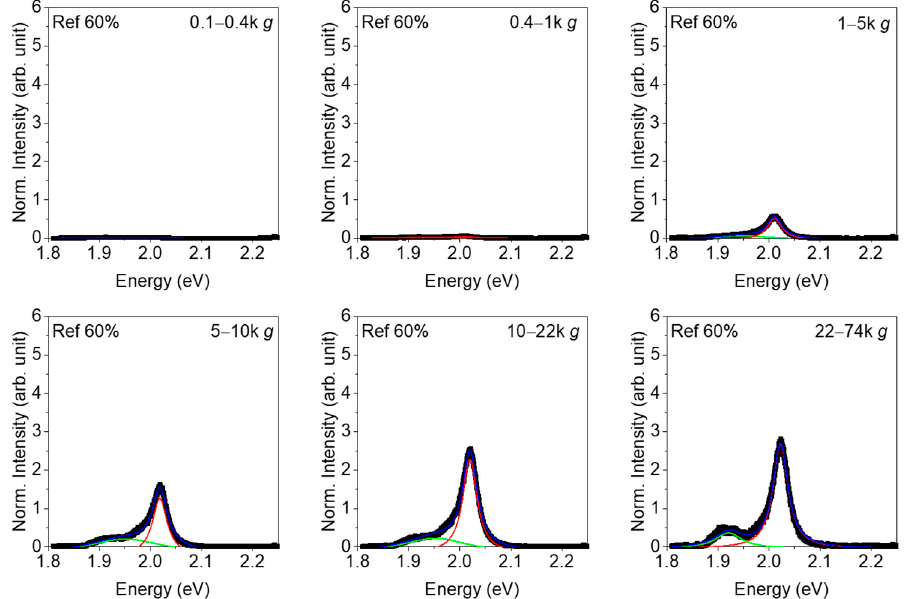
Figure A11. Photoluminescence spectra ( λ exc = 532 nm) of the reference WS 2 nanosheet dispersions, exfoliated by tip sonication with a 60% amplitude. The PL was fitted by Lorentzians for quantitative analysis.